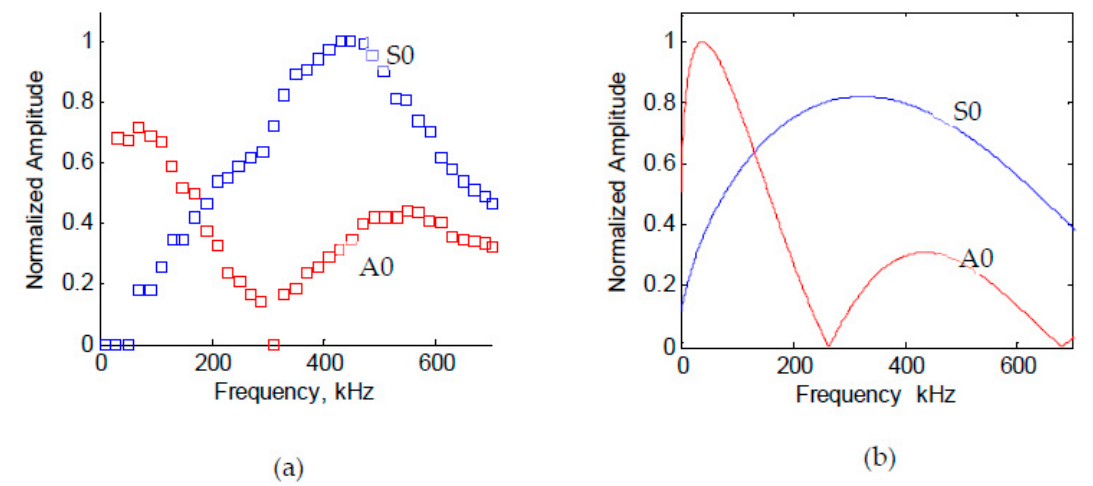
Figure 4. The Lamb wave tuning of 7 mm round PWAS on 1 mm 2024-T3 aluminum plate: ( a ) experimental results; ( b ) theoretical prediction.